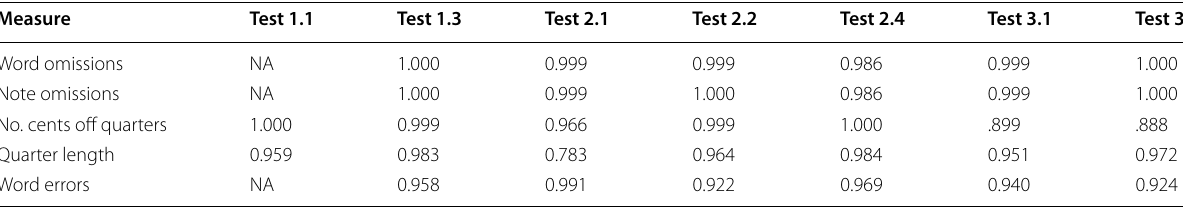
Table 6 Inter-rater reliability (Pearson’s